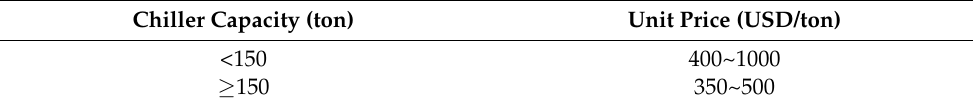
Table 17. Average cost of industrial